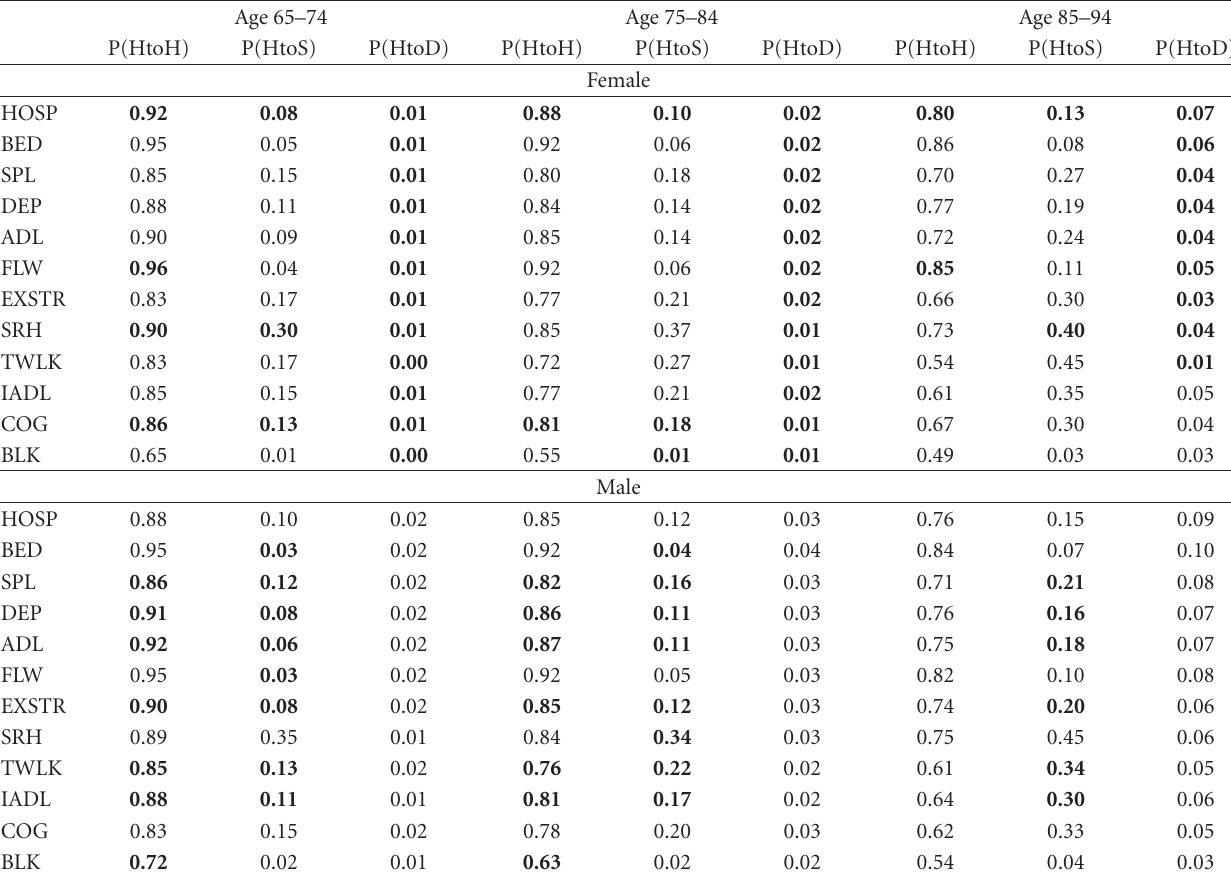
Table 3: One-year transition probabilities for those starting in a healthy state for 12 di ff erent variables. Bolded entries indicate a significantly healthier transition (more likely remaining healthy, less likely remaining sick, or less likely dying) among women compared to men (top half) or men compared to women (bottom half). The di ff erences between groups based on age are described in the